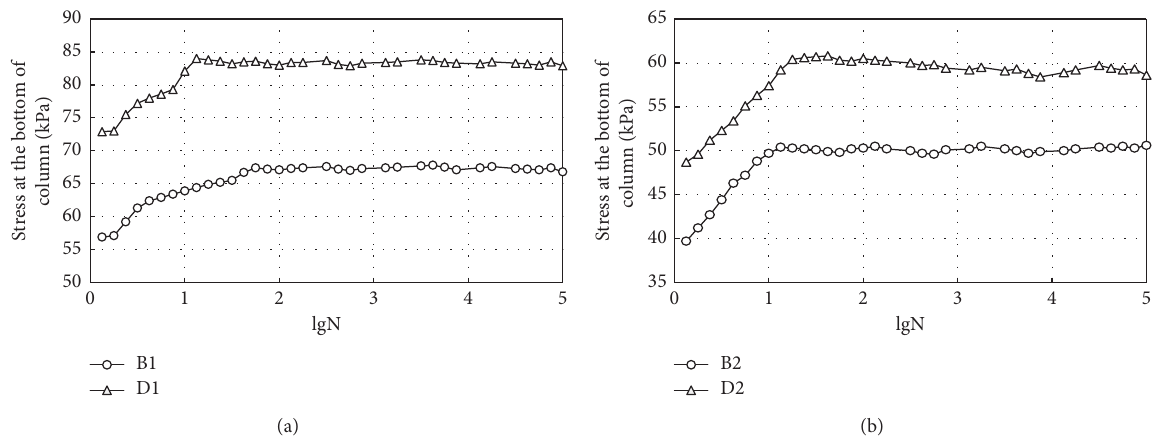
Figure 8: Compressive stress at the column bottom: (a) single column; (b) single column composite foundation. 2121.52222.52323.524